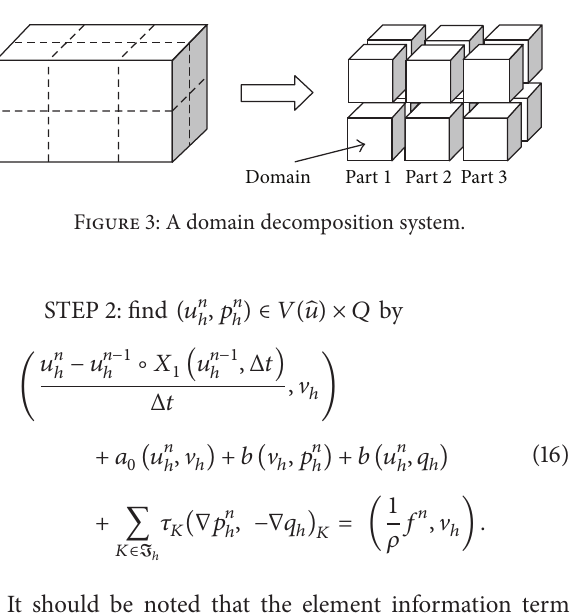
Figure 2: A 3D AGV.